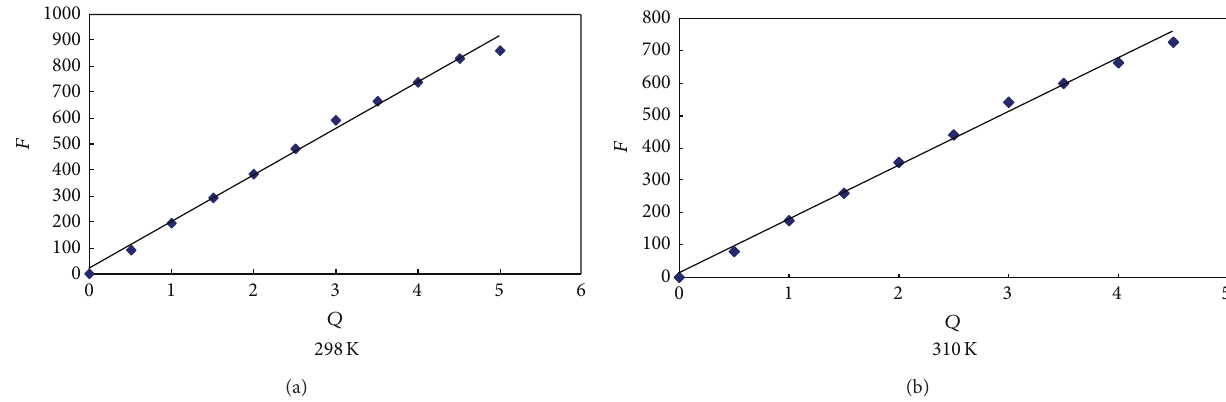
= 0, 0.5, 1, 1.5, 2, 2.5, 3,3.5, 4,4.5, 5 × 10 −6 M. HSA )